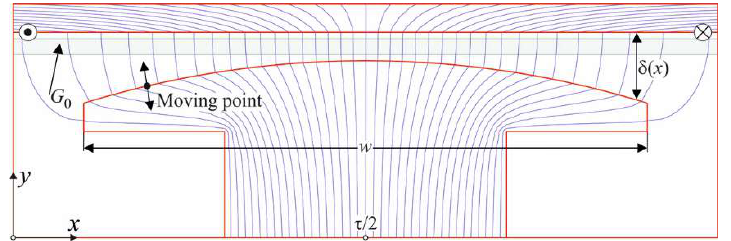
Figure 5. Symmetrical pole shoe of an SM of unknown geometry. Magnetic field distribution for the initial pole shape (the most important design variables and definitions are shown).